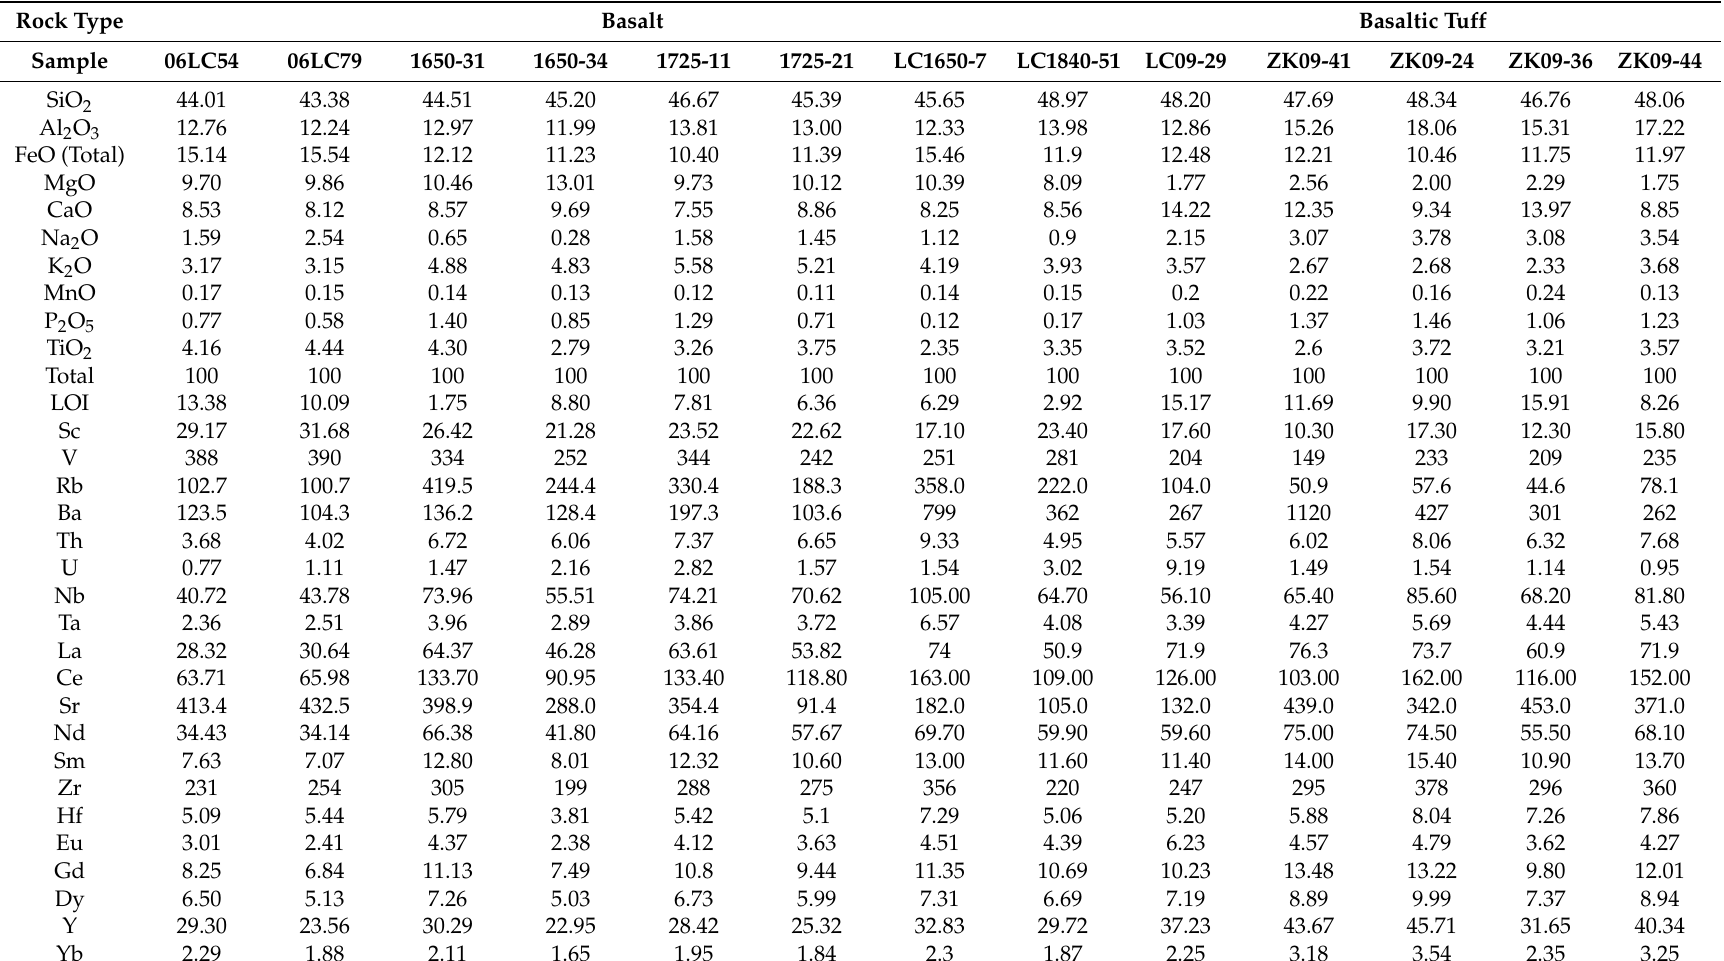
Table 1. Bulk rock composition of major (wt %) and trace elements (ppm) of Laochang basalt and basaltic